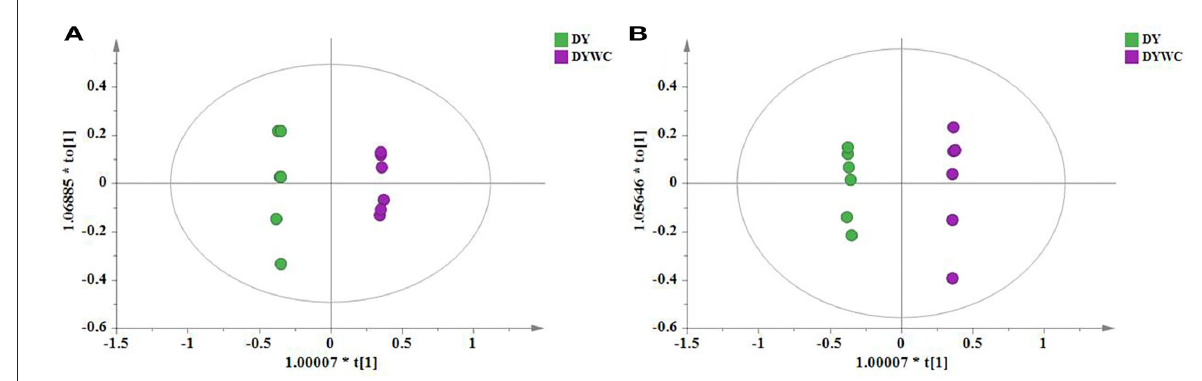
FIGURE5 OPLS-DA of DY and DYWC [ (A) positive mode; (B) negative mode].